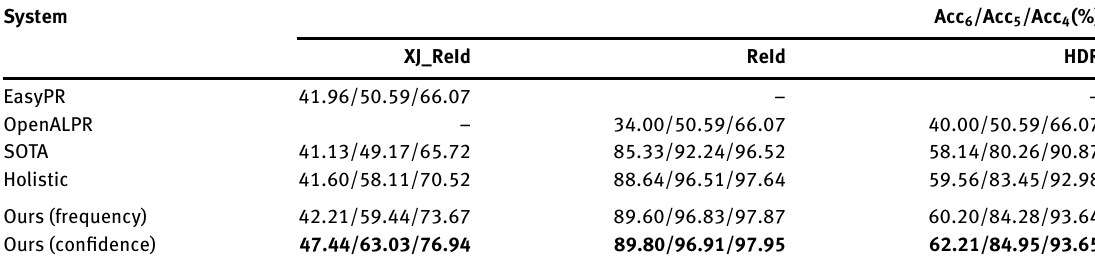
Table 2: Result of a Comparative Experiment.